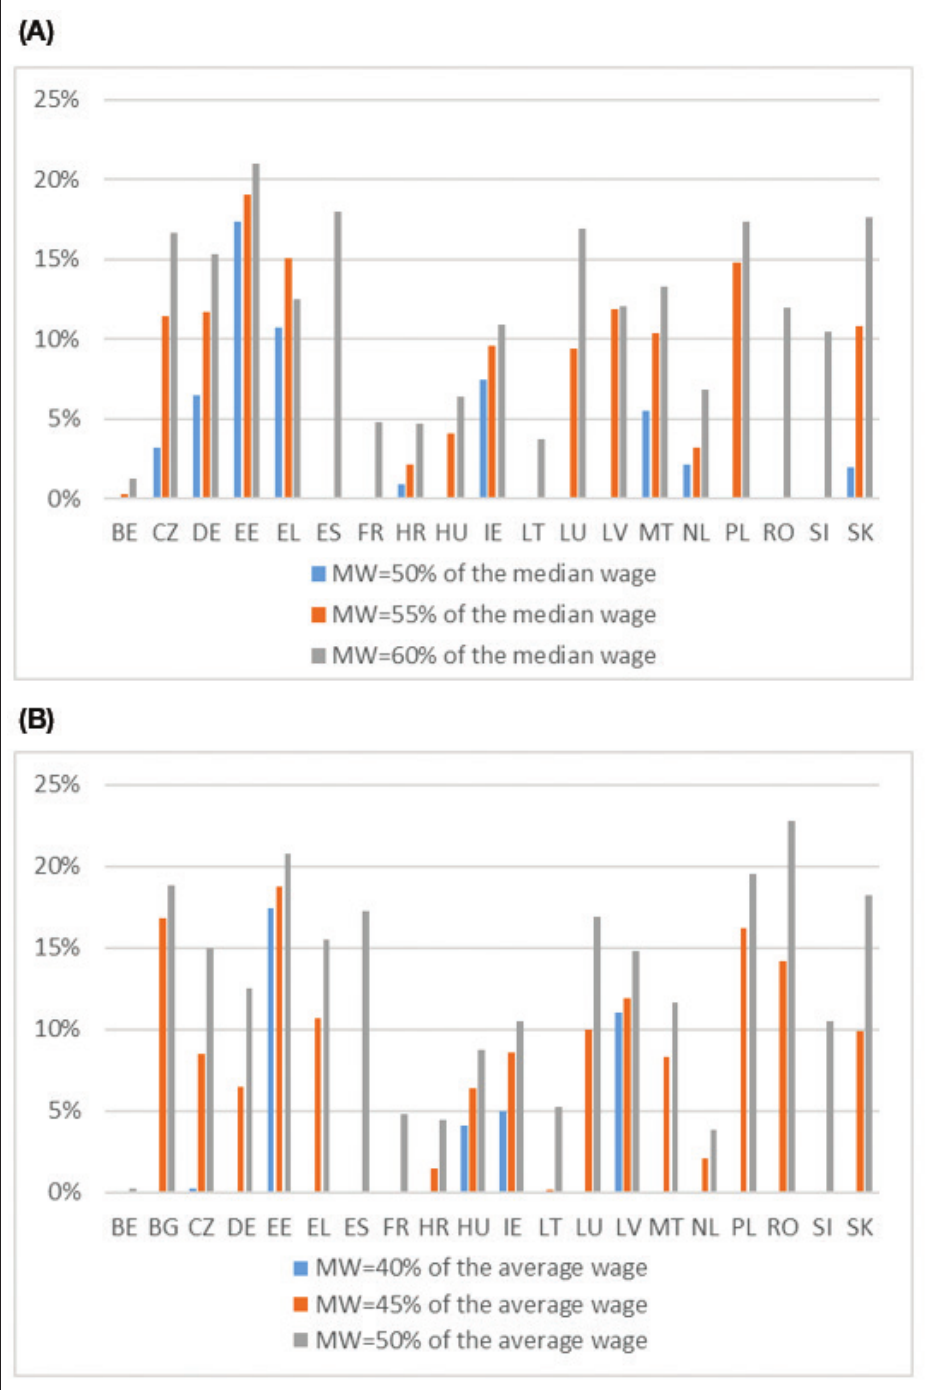
Figure A7 Reduction in wage inequality in simulated HMW scenarios, D5/D1